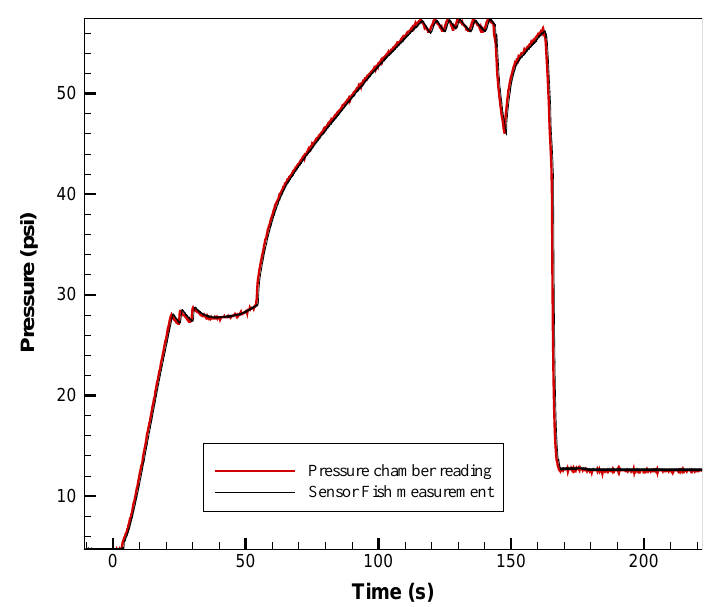
Figure 8 . The pressure sensor in Sensor Fish is calibrated in a pressure chamber at variable pressure settings and different